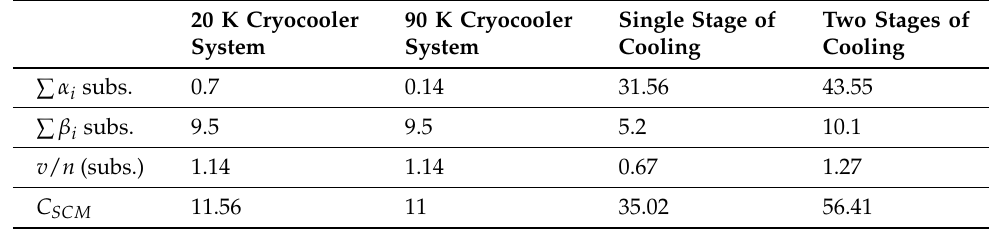
Table 8. Complexity assessment result for a thermal management system with 90 K cryocooler component complexity of 0.02 and a 20 K Cryocooler component complexity of